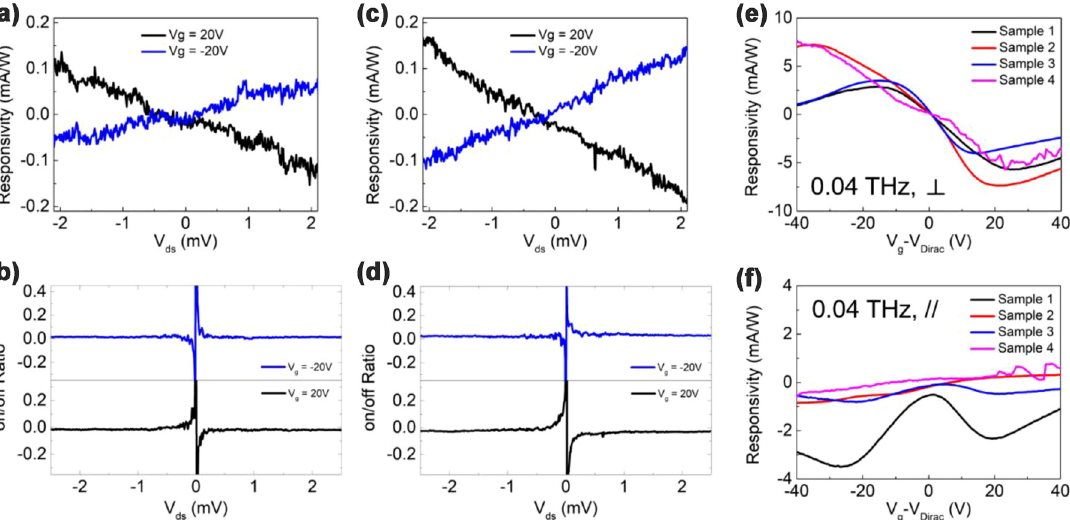
Figure 2: The responsivity and on/off ratio under 0.04 THz illumination. (a) The responsivity of Sample 1 as a function of source-drain bias with the gate voltage fixed at 20 V and − 20 V, respectively. (b) The on/off ratio corresponding to (a). (c) The responsivity of Sample 2 as a function of source–drain bias with the gate voltage fixed at 20 V and − 20 V, respectively. (d) The on/off ratio corresponding to (c). (e) The responsivity of the 4 devices as a function of gate voltage with source-drain bias fixed at 0.1 V, and the incidence polarization perpendicular to the graphene ribbons. (f) The responsivity of the 4 devices as a function of gate voltage with source-drain bias fixed at 0.1 V, and the incidence polarization parallel to the graphene